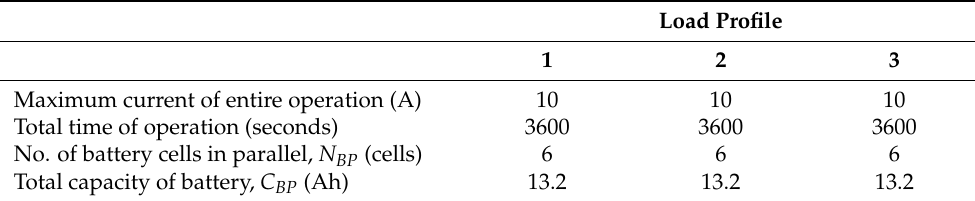
Table 8. Sizing results of the battery-only